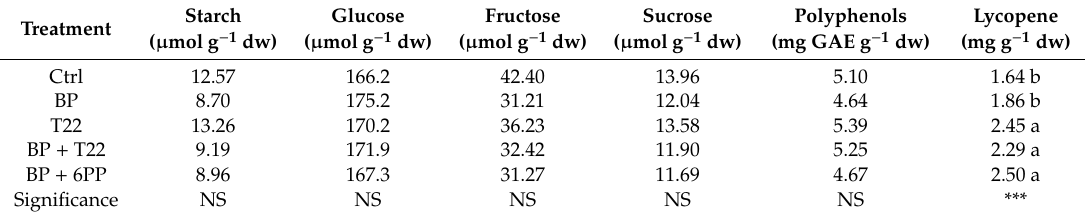
Table 2. E ff ects of applications of Trichoderma harzianum strain T22 (T22) or biopolymer (BP) alone or in combinations (BP + T22 or BP + 6PP) on the content of starch, glucose, fructose, sucrose, polyphenol and lycopene in greenhouse Pixel tomato fruits. The control was not treated with biostimulants (Ctrl).